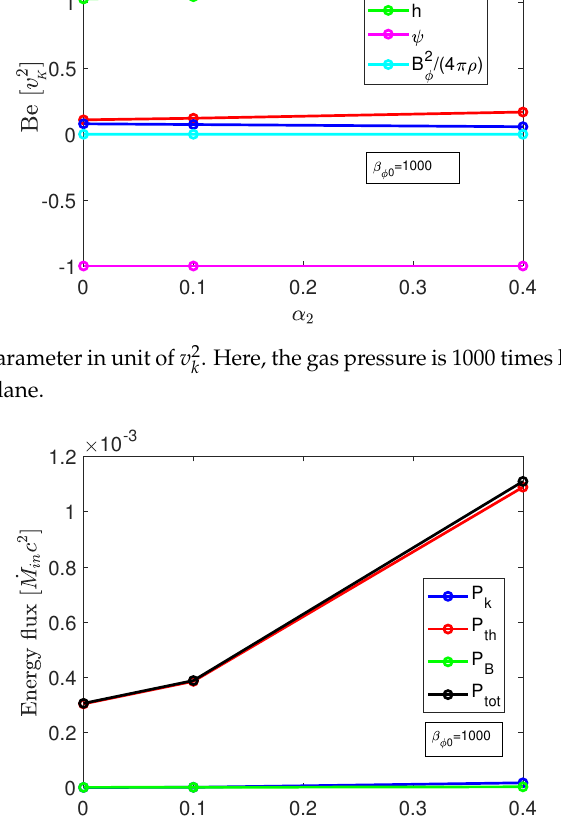
Figure 4. Energy fluxes carried by outflow. Here, the gas pressure is 1000 times larger than the magnetic pressure at the